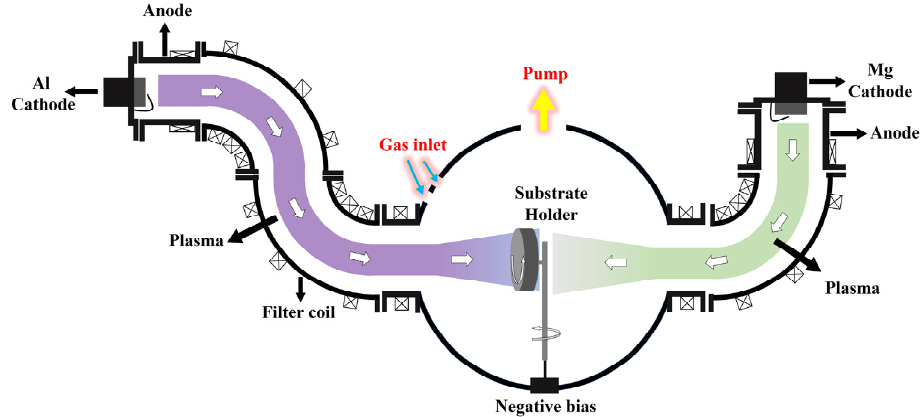
Figure 1. Schematic diagram of FCVA equipment used for deposition.